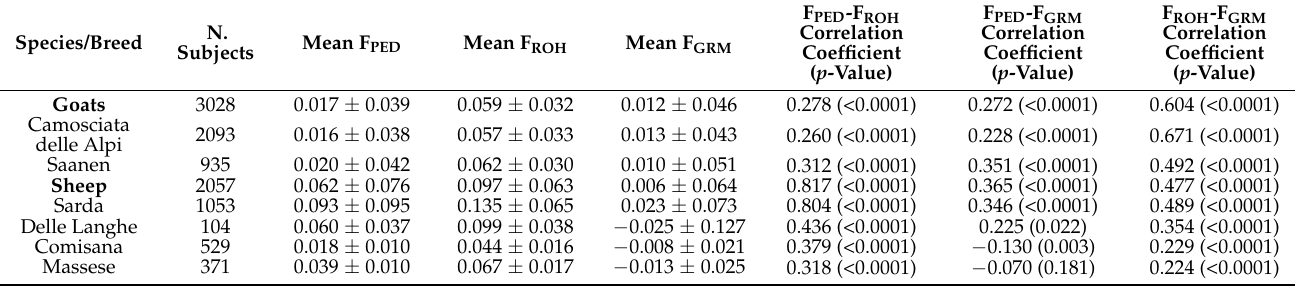
Table 1. Number of subjects in the final dataset for each species and breed, relative mean value of pedigree, ROH and GRM-based inbreeding coefficients (F PED , F ROH and F GRM ) and their correla- tion